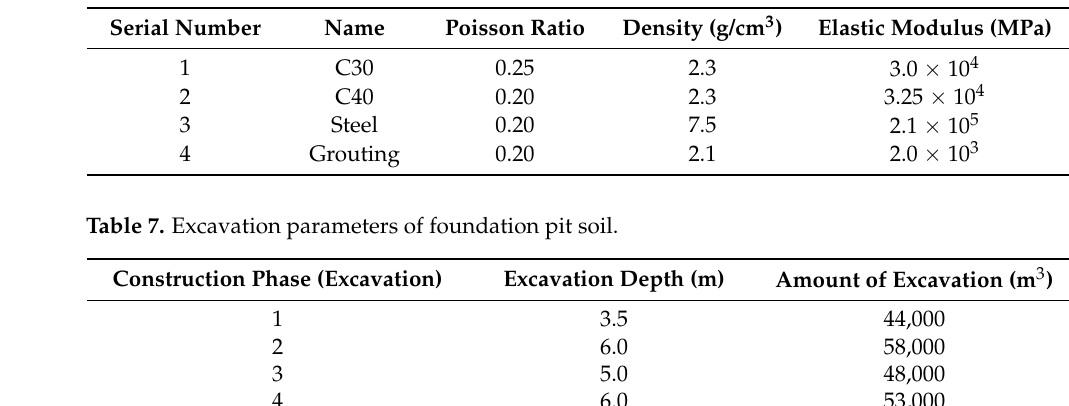
Table 6. Finite element model to simulate material parameters.